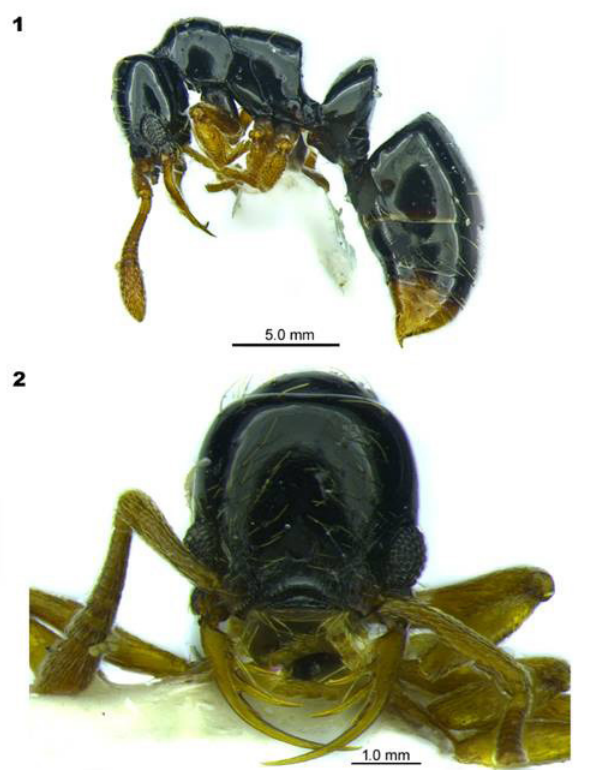
Plate 2 . Thaumatomyrmex fraxini sp. nov., holotype worker [LBSA_ SA_14015217]. Fig. 3: mesosoma, dorsal view. Fig. 4: petiole, dorsal view.